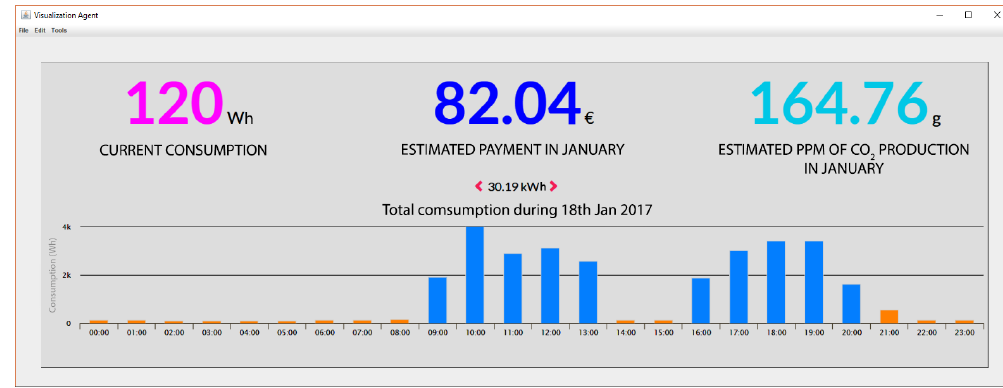
Figure 18. Details about consumption, invoice, CO 2 production on a specific day.